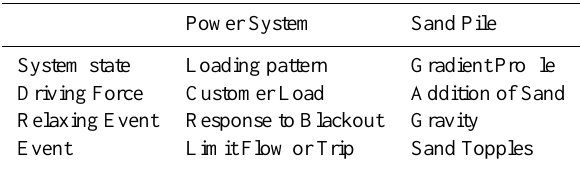
Table 3. Analogy between a power system and a sandpile. Adapted from Carreras et al.